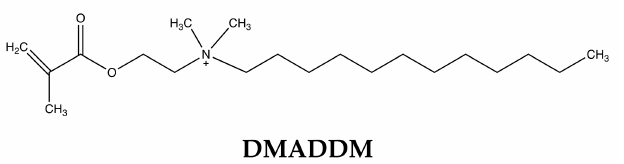
Figure 8. Chemical Structure of quaternary ammonium monomer. Dimethylaminododecyl methacry- late (DMADDM), n =